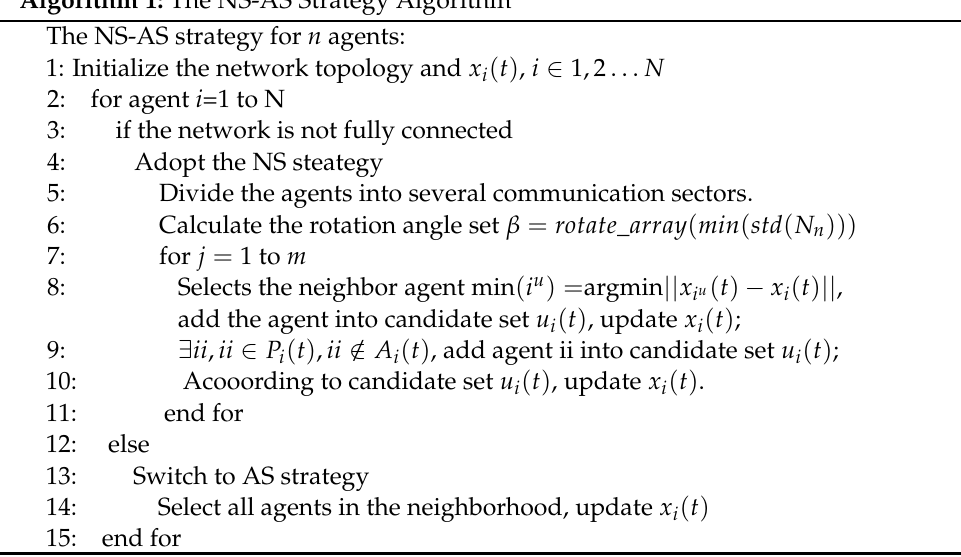
Algorithm 1: The NS-AS Strategy